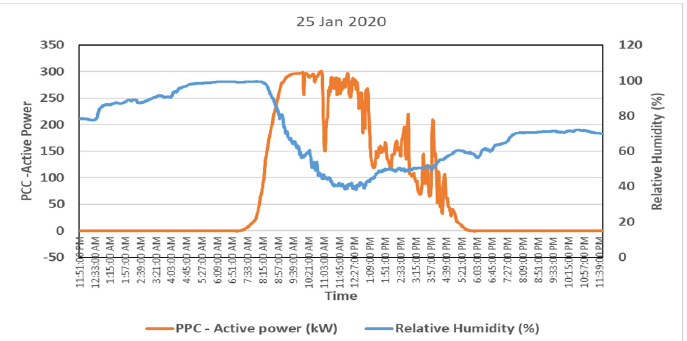
Figure 18. Active power vs. relative humidity on a very humid day.